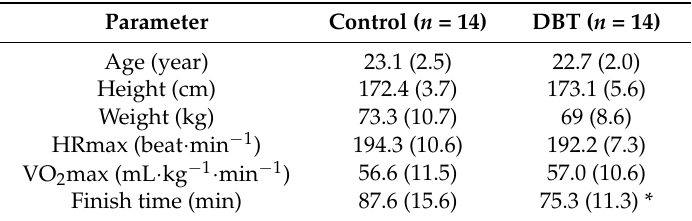
Table 2. Characteristics of participants.